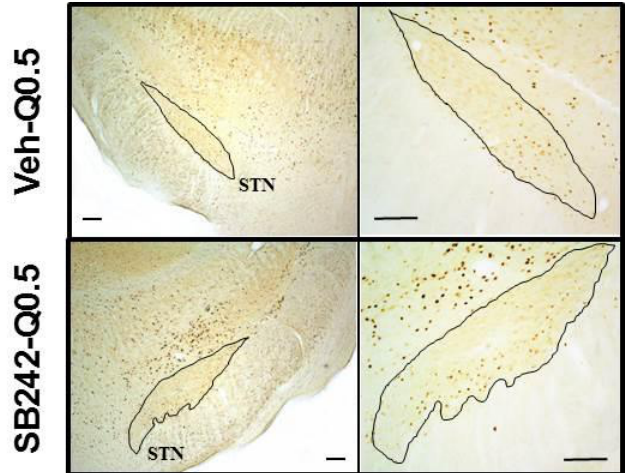
Figure 3. Photomicrographs illustrating c-Fos-like immunoreactive cells at the level of the rat STN. It shows c-Fos labelled cells in a rat receiving quinpirole alone (0.5 mg/kg; Veh-Q0.5; top squares) or in a rat receiving the combination of quinpirole with SB 242084 (1 mg/kg; SB242-Q0.5; bottom squares). SB 242084 enhanced the number of c-Fos-positive cells induced by quinpirole in STN. Scale bar in the left and right squares: 200 and 100 µm, respectively.